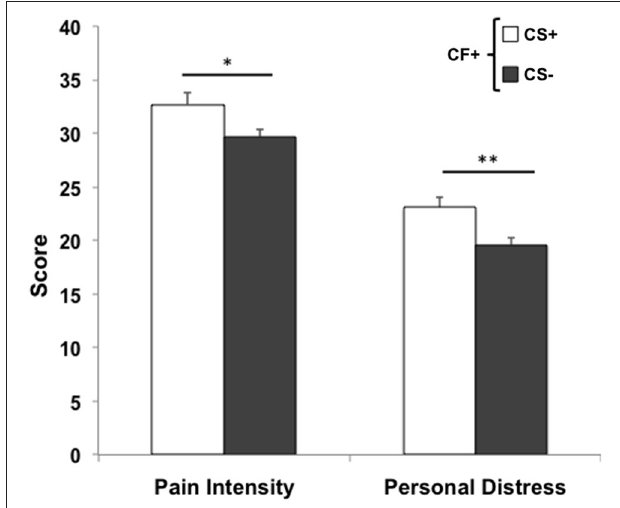
FIGURE 4 | Compassion Fatigue and Satisfaction . Within participants who experience compassion fatigue (CF+), those who also experience compassion satisfaction (CS+) perceive targets’ pain more intensely (* p < 0.05) and elicit stronger self-oriented distress (** p = 0.01) than participants who do not experience compassion satisfaction (CS − ). Error bars are S.E.M